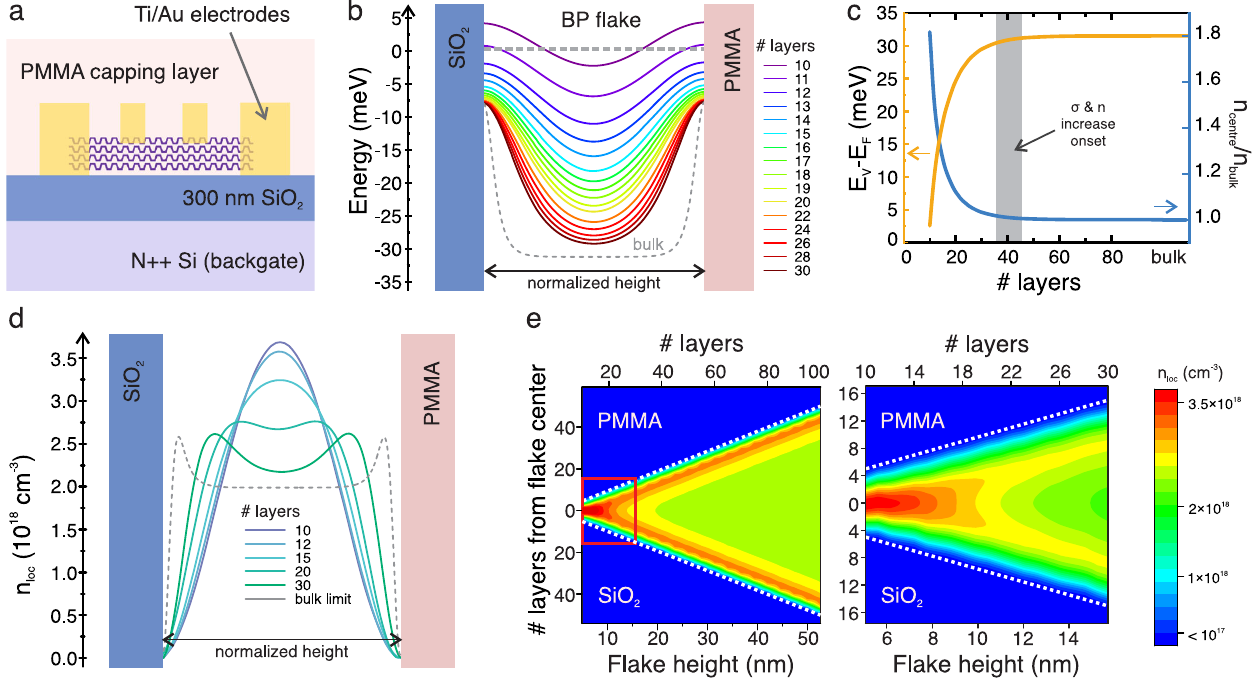
Fig. 3 Space charge region formation and local redistribution of majority charge carriers in multilayer BP close to the fl ake surfaces. a Schematic diagram depicting an electrically contacted BP multilayer on a SiO 2 substrate capped with a PMMA protective layer. b Valence band energies within BP with layer number varied from 30 to 10. The dashed grey line denotes the VB position expected in bulk BP as a reference. For clarity, the fl ake heights are normalised as indicated by the double arrow. c Layer number dependence of the VB bottom energies (orange) and associated with it the augmentation of local carrier density within the central layers of BP fl akes. d Examples of local distribution of carriers within BP fl akes of different layer numbers ( fl ake heights normalised as in ( b ) and e the corresponding colour maps depicting local carrier densities within BP fl akes as a function of height/layer number. As the layer number is reduced, the majority of charge carriers become con fi ned to the innermost layers. Already for fl akes with heights of 10 nm, the free holes are electrically con fi ned into the innermost 1 – 2 layers, with the carrier-depleted layers not contributing to the charge transport. In all calculations, the average carried density of 2 × 10 18 cm − 3 was